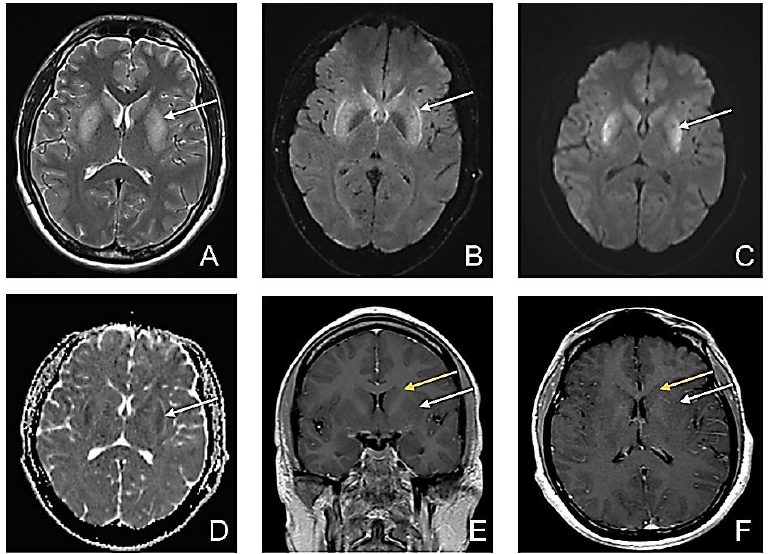
Figure 2. Second MRI-D5. ( A ) Axial T2-weighted image sequence: bilateral putaminal high signal intensity; ( B ) Axial FLAIR sequence: bilateral putaminal high signal intensity; ( C ) Axial DWI: high signal intensity in putaminal regions; ( D ) Axial ADC map: low ADC in the putaminal regions suggestive of restricted diffusion in both putaminal regions (white arrow); ( E ) Contrast-enhanced Coronal T1wi; and ( F ) Contrast-enhanced Axial T1wi: no enhancement in the bilateral caudate nucleus (yellow arrow) and putamen (white arrow) with slightly decreased signal in bilateral putamen.